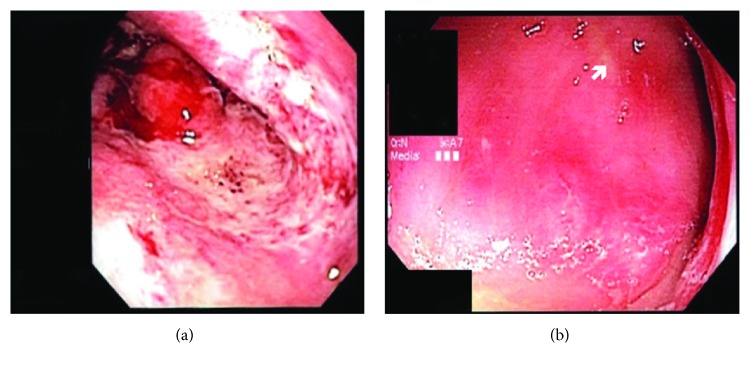
Endoscopy images of patient with necrotic stomach (a). Focal ulceration (denoted by the arrow) and inflammation can be seen on the patient's colonoscopy (b).